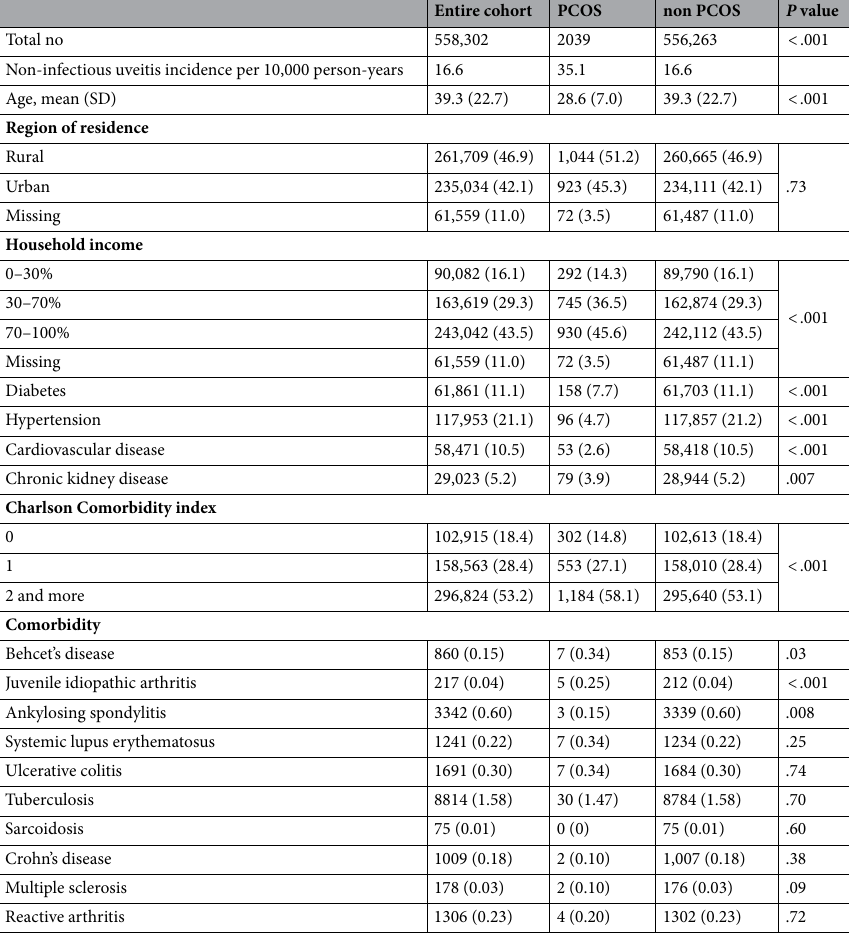
Table 1. Baseline characteristics of women in cohort data. PCOS Polycystic ovary syndrome. Data are presented as No.